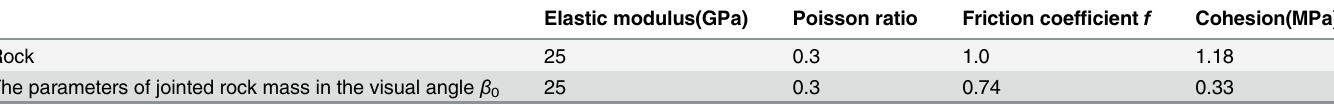
The parameters of jointed rock mass in the visual angle β